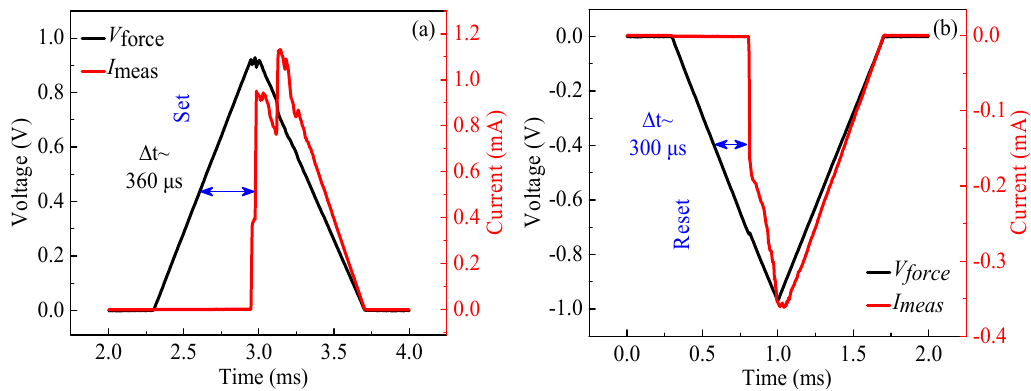
Figure 7. The switching time of the LZO-5 device at a pulse voltage: ( a ) set; ( b ) reset.